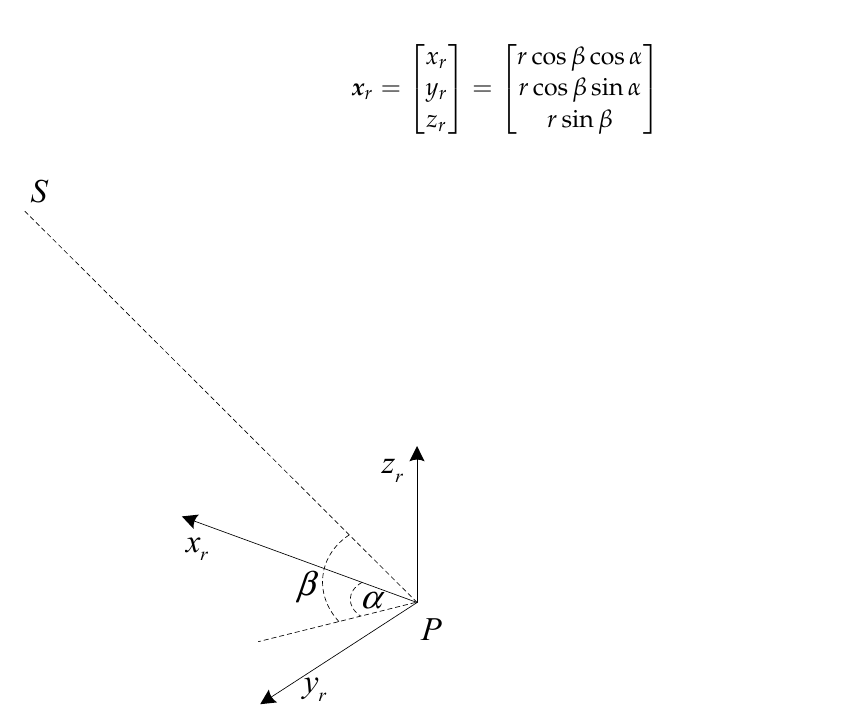
Figure 3. Cartesian and Spherical coordinate system.